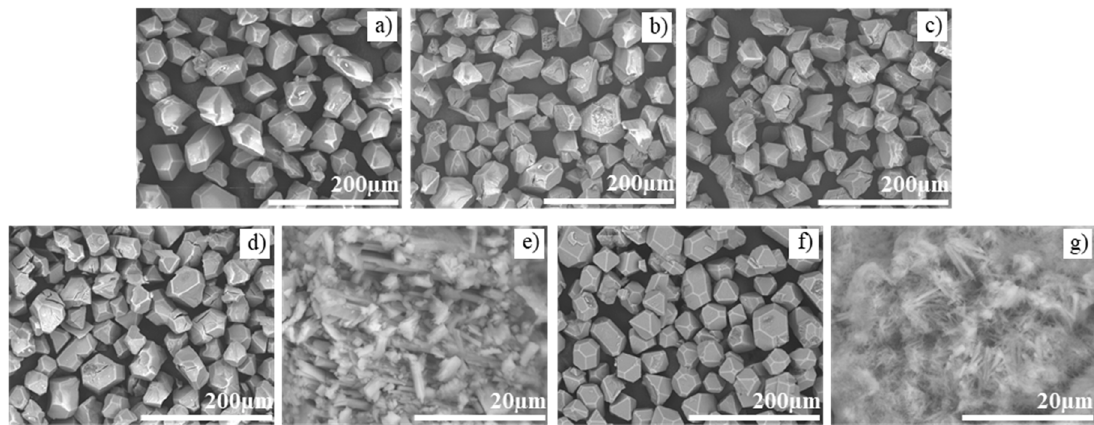
Figure 5. Representative SEM images of HKUST-1 powder (obtained commercially as Basolite ® C 300) ( a ) before gas exposure; ( b ) after NH 3 exposure without activation; ( c ) after NH 3 exposure with prior activation; ( d ) after H 2 O vapor exposure; ( e ) after H 2 O vapor and subsequent NH 3 exposure without activation; ( f ) after DMSO exposure; ( g ) after DMSO and subsequent NH 3 exposure without activation.